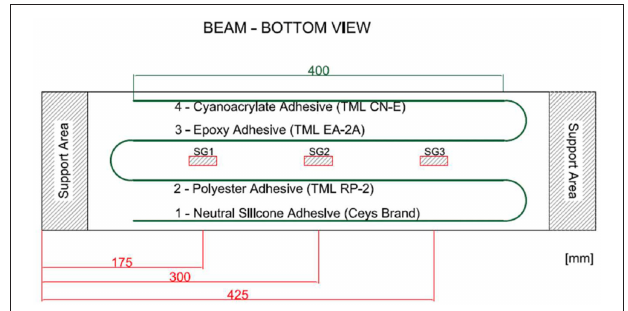
Frontiers in Built Environment |